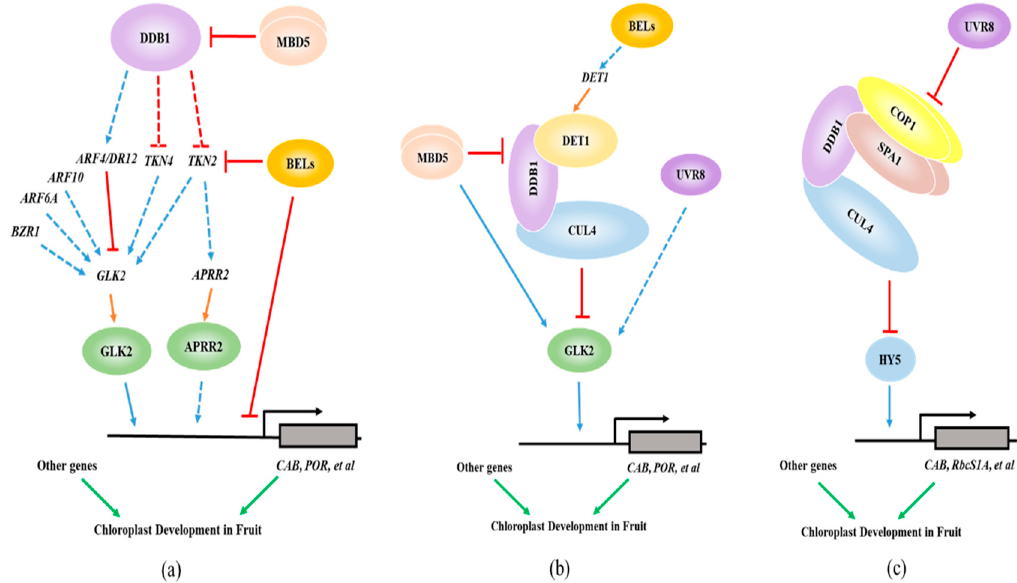
Figure 2. Models for the transcriptional regulation of chloroplast development in unripe fleshy fruit. ( a ) The regulation of GLK2 and APRR2 transcription levels to control chloroplast development in fruit. The KNOX genes TKN2 and TKN4 positively a ff ect GLK2 and APRR2 expression to promote chloroplast development. Auxin, via ARFs , regulate the expression of GLK2 , whereas brassinosteroids (BRs), via BZR1-1D , promote GLK2 expression (Liu et al., 2014). TKN2 regulates the expression of both GLK2 and APRR2 , whereas TKN4 only regulates the expression of GLK2 . DDB1 acts upstream of ARF4 / DR12 , TKN4 and TKN2 to regulate their expression. The MBD5 dimer blocks DDB1 regulating downstream genes. In addition, BEL11 directly represses the transcription of TKN2 , CAB and POR by binding their promoters. ( b ) Proteasomal degradation of transcriptional regulator GLK2. The CUL4-DDB1-DET1 ubiquitin ligase complex targets GLK2 for proteasomal degradation. MBD5 inhibits this